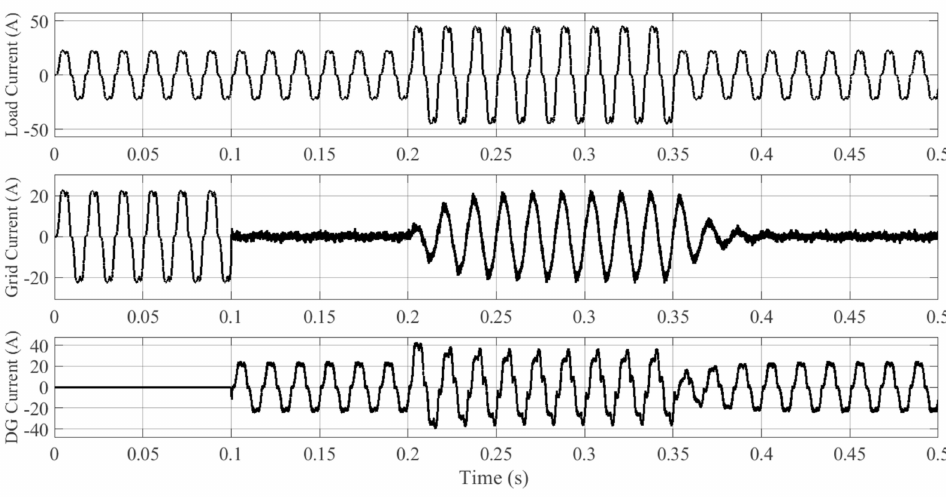
Figure 13. TL VSI simulation